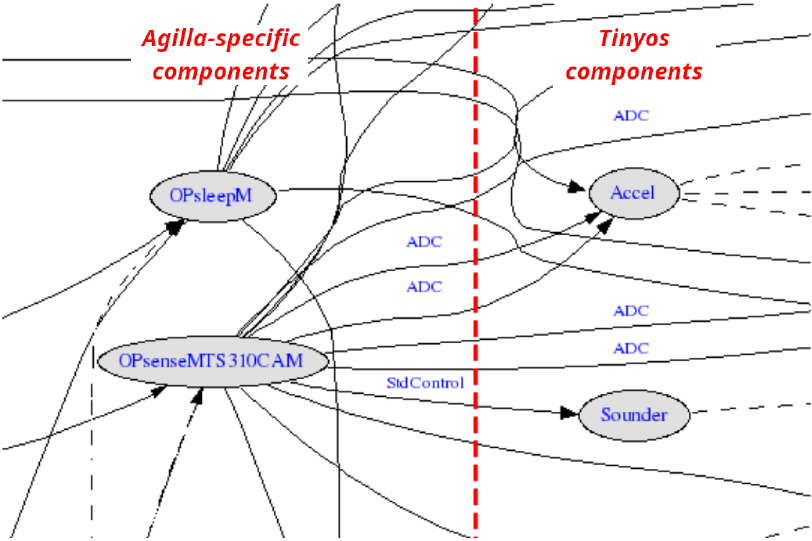
Figure 5. Agilla ( left ) and TinyOS ( right ) “virtual” component separation